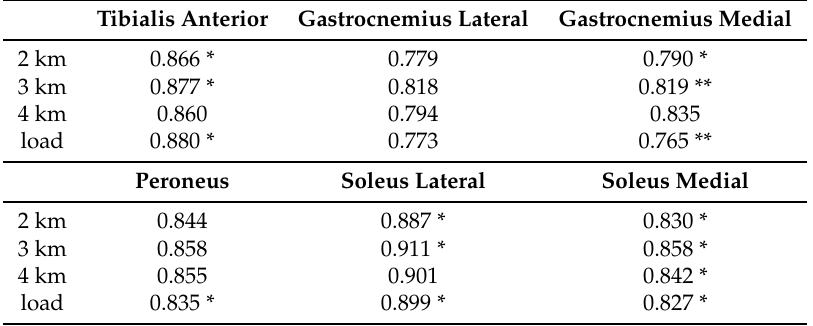
Table 7. Median spatial accuracy [%] of each task of the proposed method (* p < 0.05, ** p <